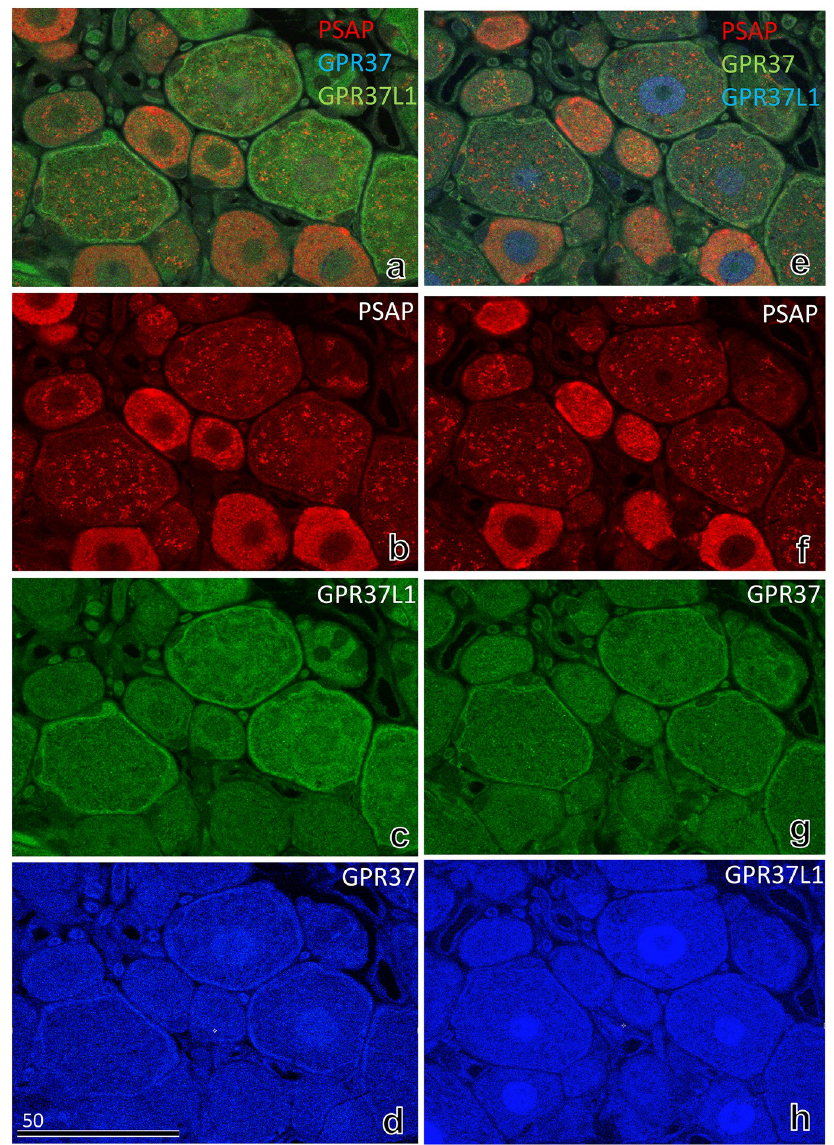
Fig 7. Immunofluorescence light micrographs of the rat DRG at 8 weeks, stained with antibodies against PSAP (red), GPR37L1 (green), and GPR37 (blue) (a–d). The neighbouring section was stained with antibodies against PSAP (red), GPR37 (green), and GPR37L1 (blue) (e–h). The intensity of GPR37L1-IR in satellite cells was stronger than that of GPR37-IR (c, h). The numbers on the bars indicate the scale in μ